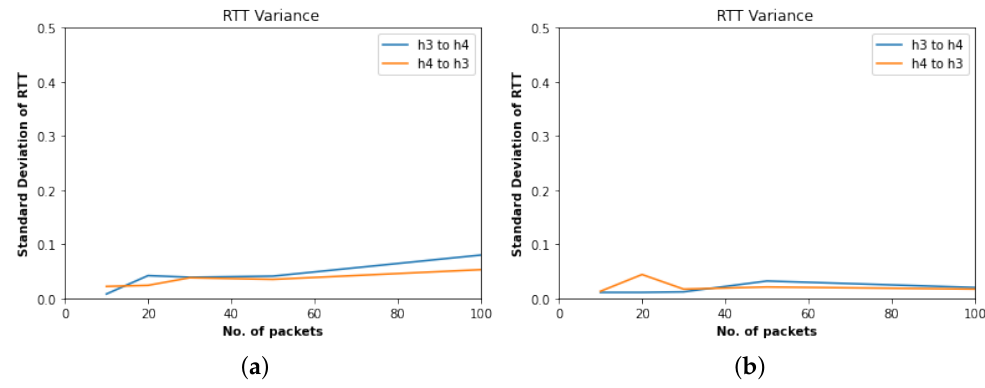
Figure 12. RTT Variance, ( a ) Within AS65000 in Legacy, and ( b ) within SDN. RTT, Round Trip Time.